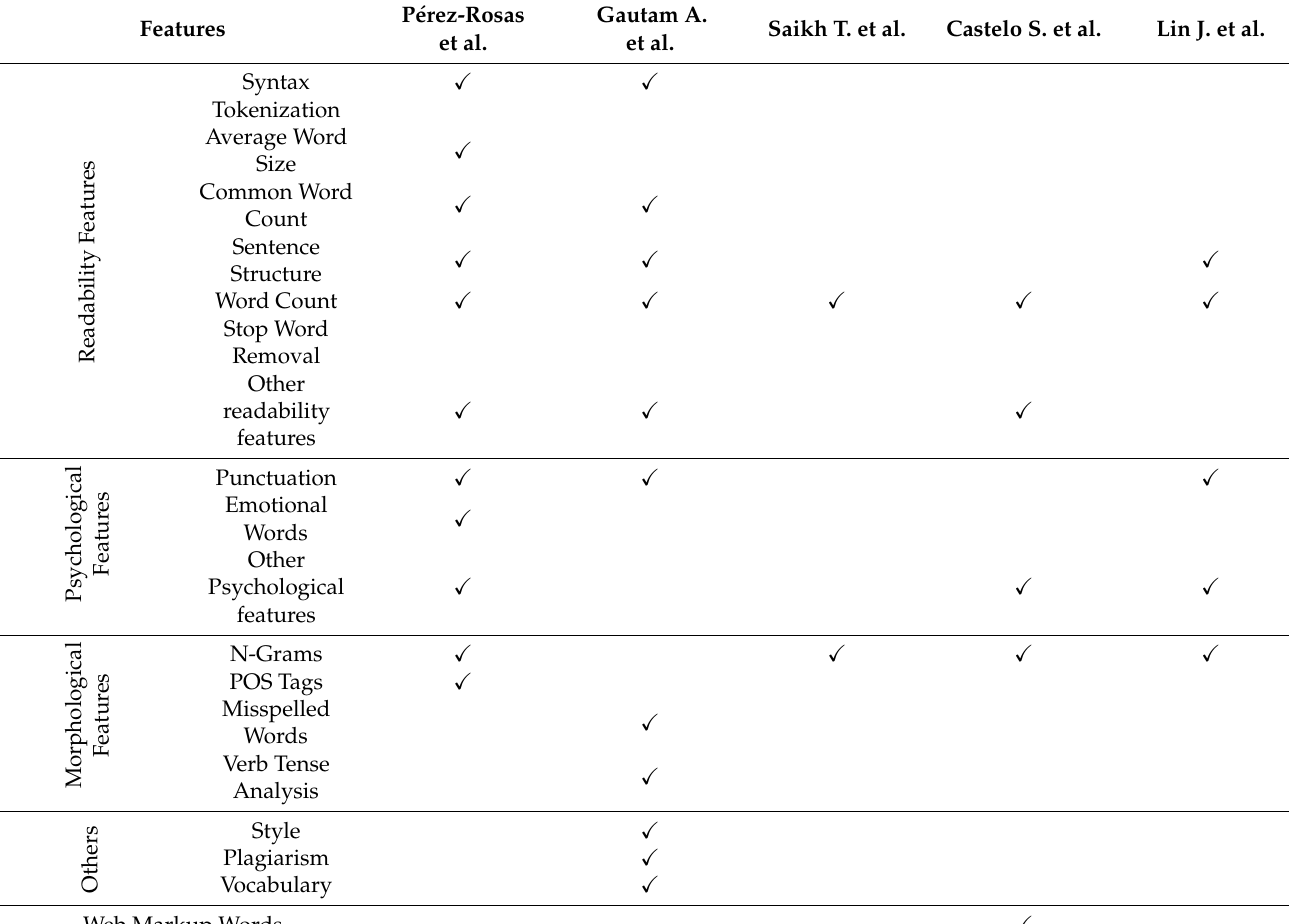
Table 5. Data Pre-Processing Features used in Cross-Domain Methodologies.